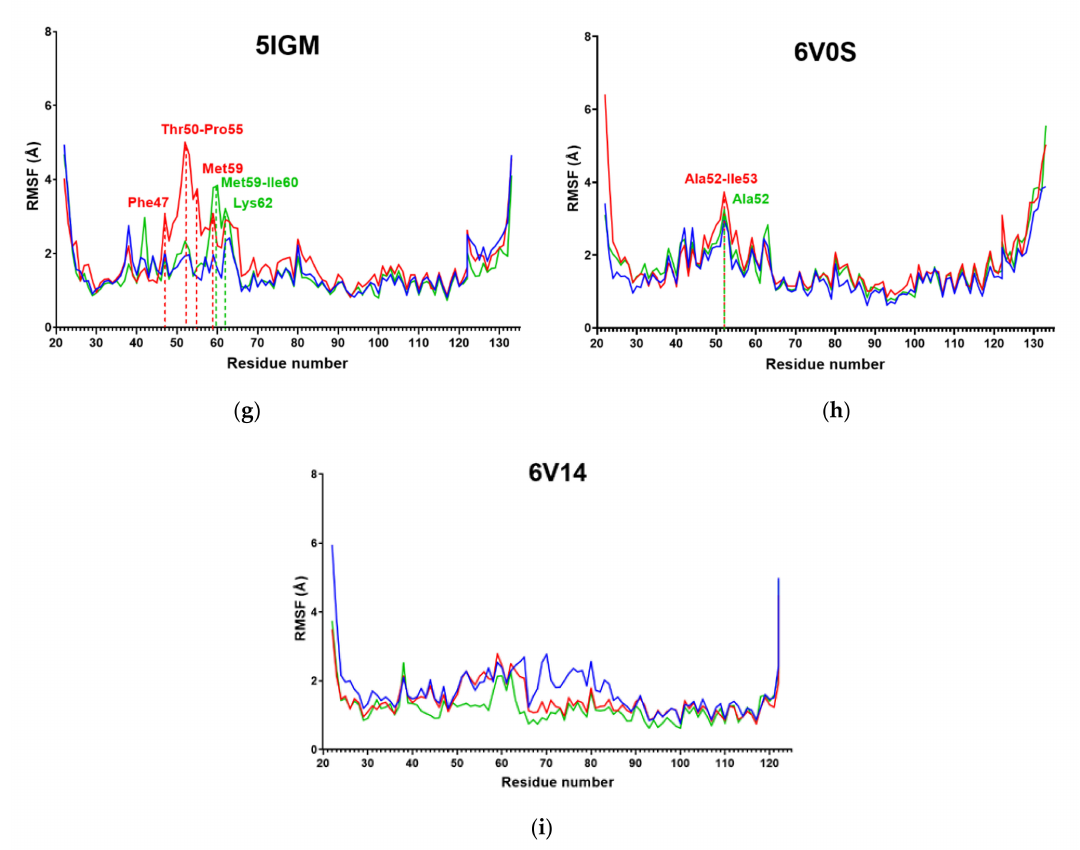
Table 4. Protein residues with a mean RMSF value above 4 Å. Key binding site residues are in bold. System Amino Acids with Mean RMSF above 4 Å Phe47, Thr50, Asp51, Ala52, Ile53 , Ala54, Apo Pro55, Met59, Ile60, Lys62 4UIW / 4XY8 Asp51, Ala52, Ile53 4Z6I Ala52, Ile53 , Pro55, Lys62 5E9V Met59 5F1H / 5IGM Ala52 6V0S Ala52 6V14